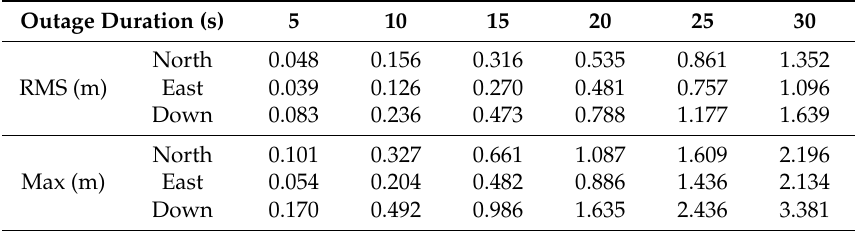
Table 5. Statistics of position drift error of the tightly-coupled RTK/INS integration during